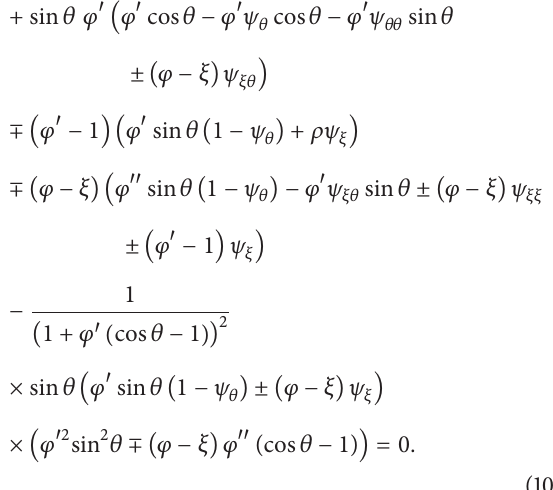
𝑝 def against the